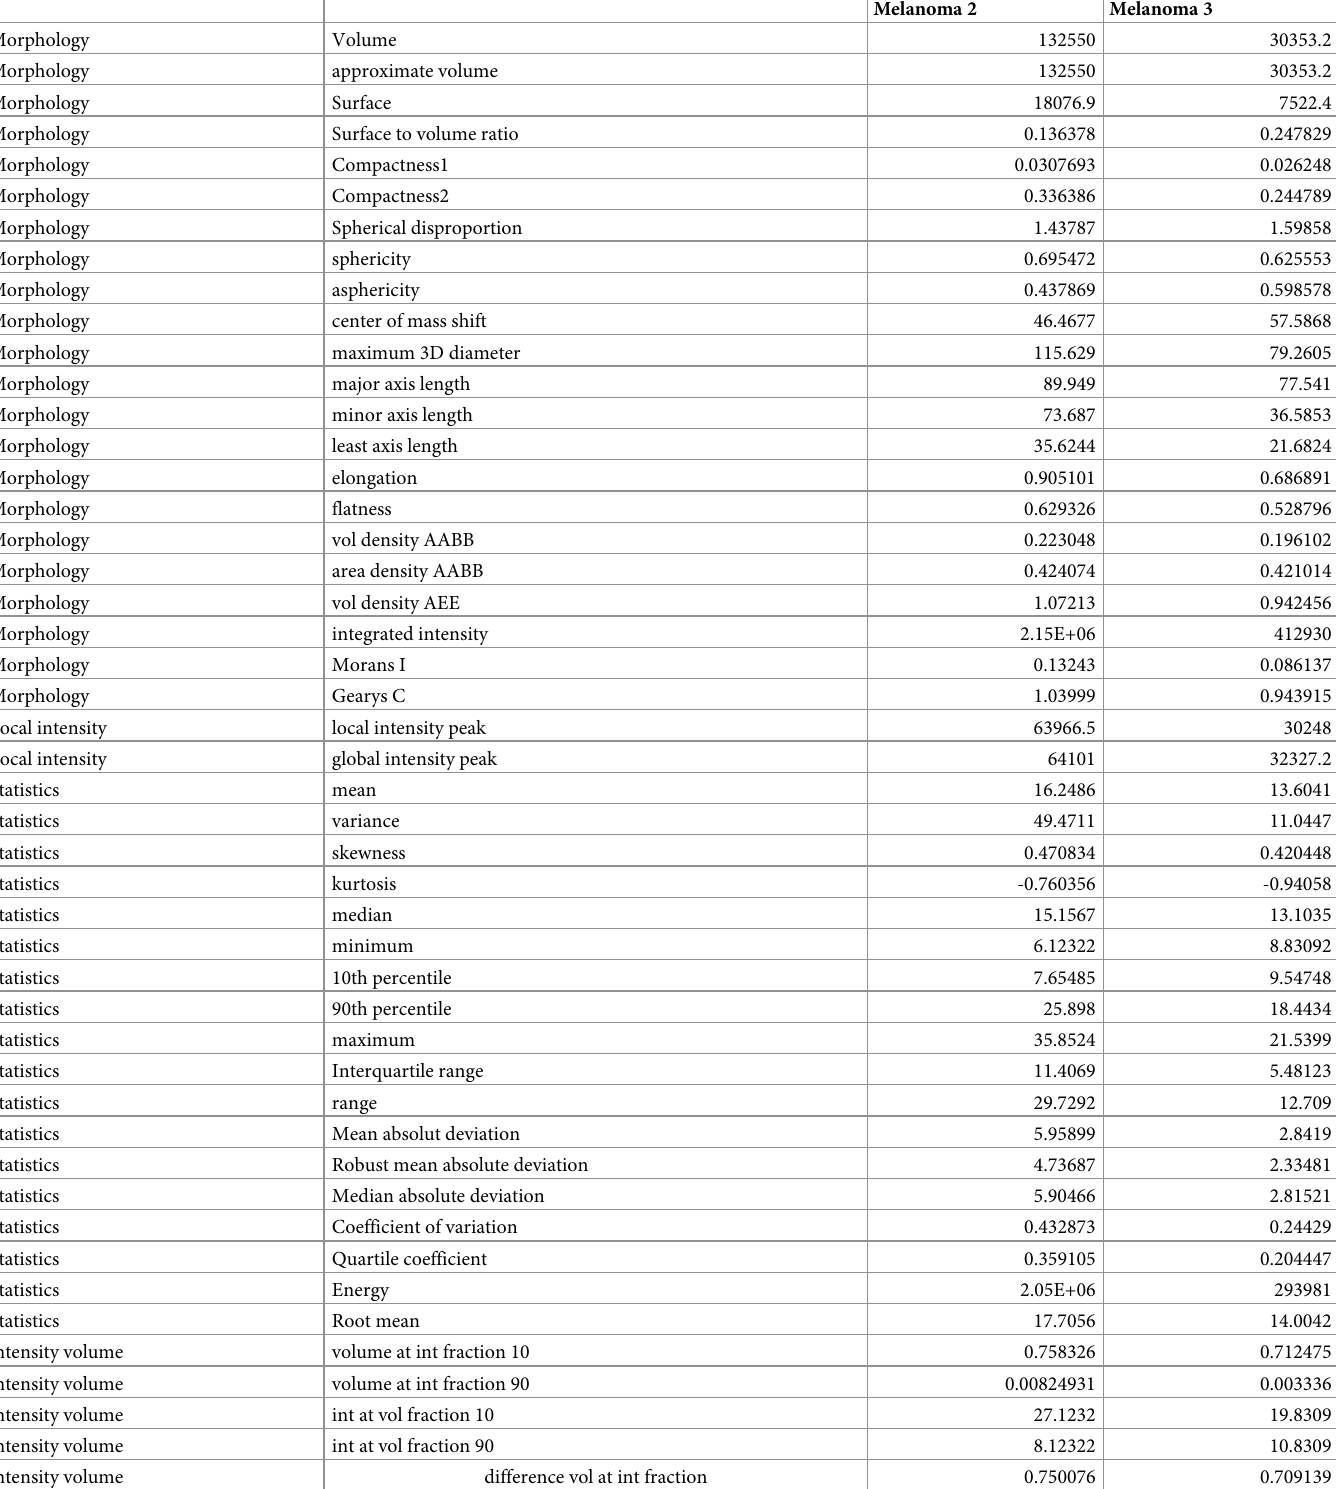
Table 4. Radiomic features extracted from cancer